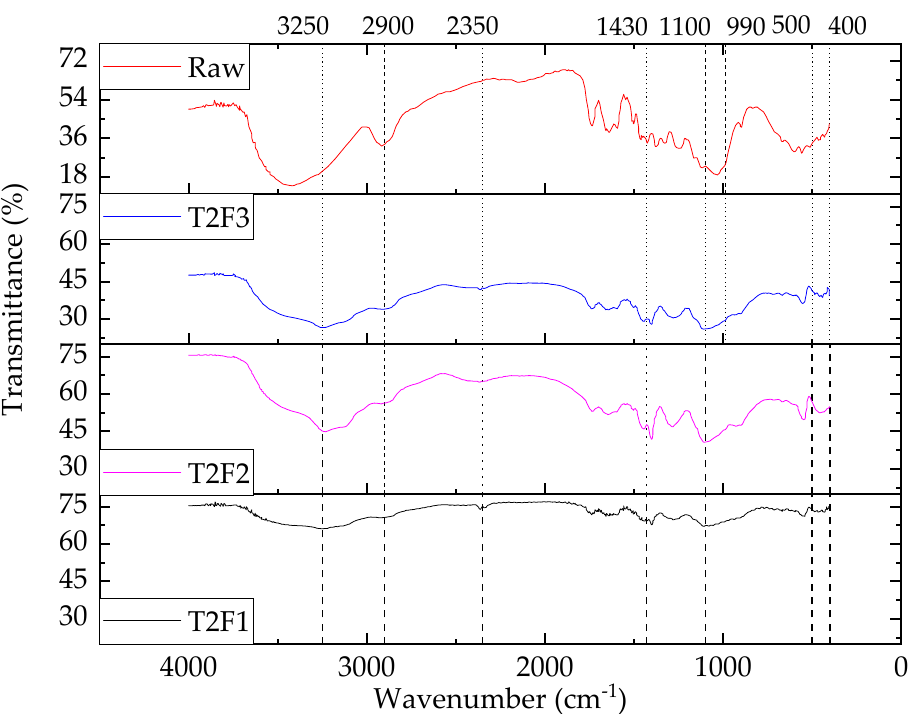
Figure 11. FTIR transmission spectra of fire retardant (T2)-treated jute fibers.